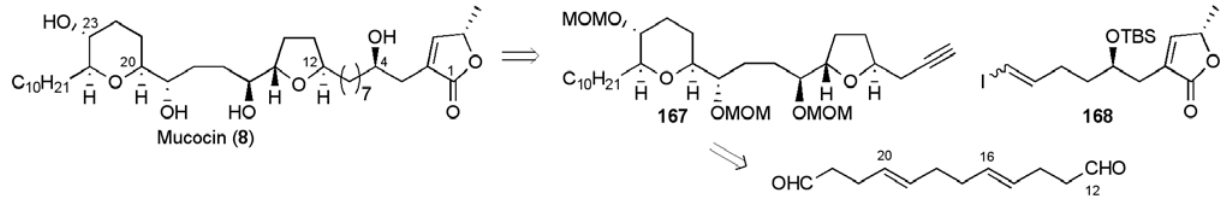
Figure 22. Nakata’s retrosynthetic analysis of mucocin ( 8 )